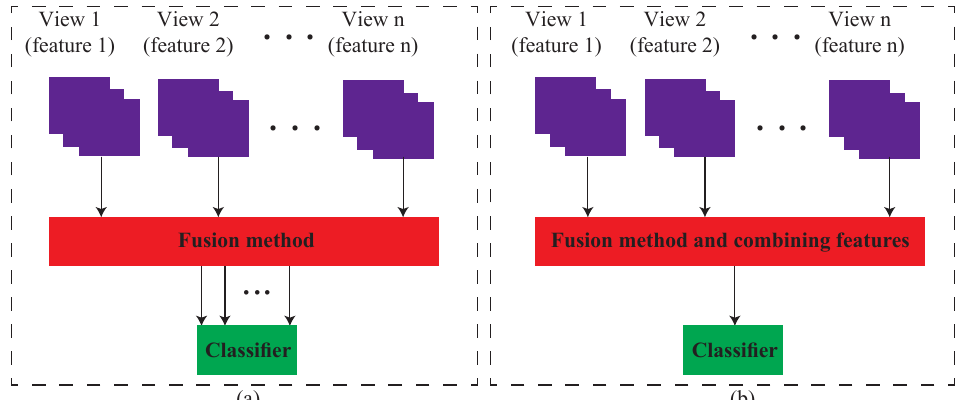
Figure 2. Different structures for multi-feature fusion. ( a ) multiple views are sent to classifier without reducing them (our approach) ( b ) Views are reduced into one